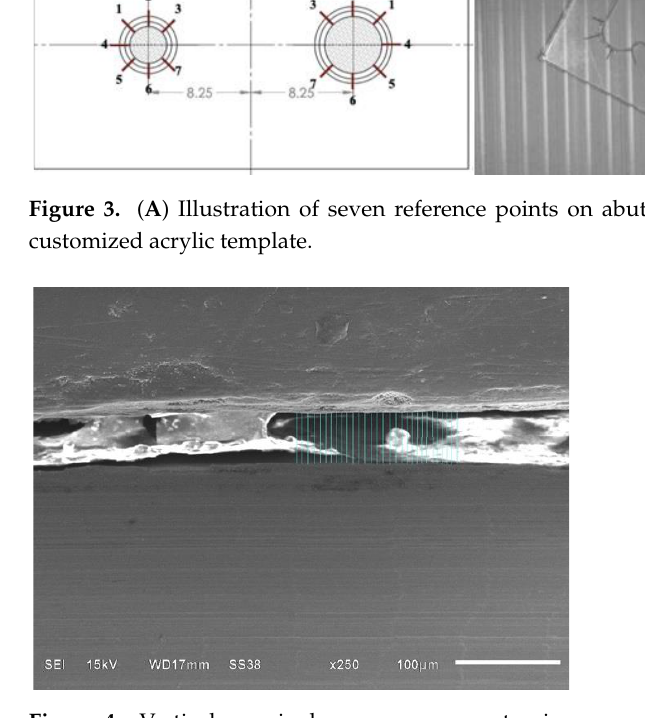
Figure 4. Vertical marginal gap measurement using a scanning electron microscope (SEM) at ×250 magnification.